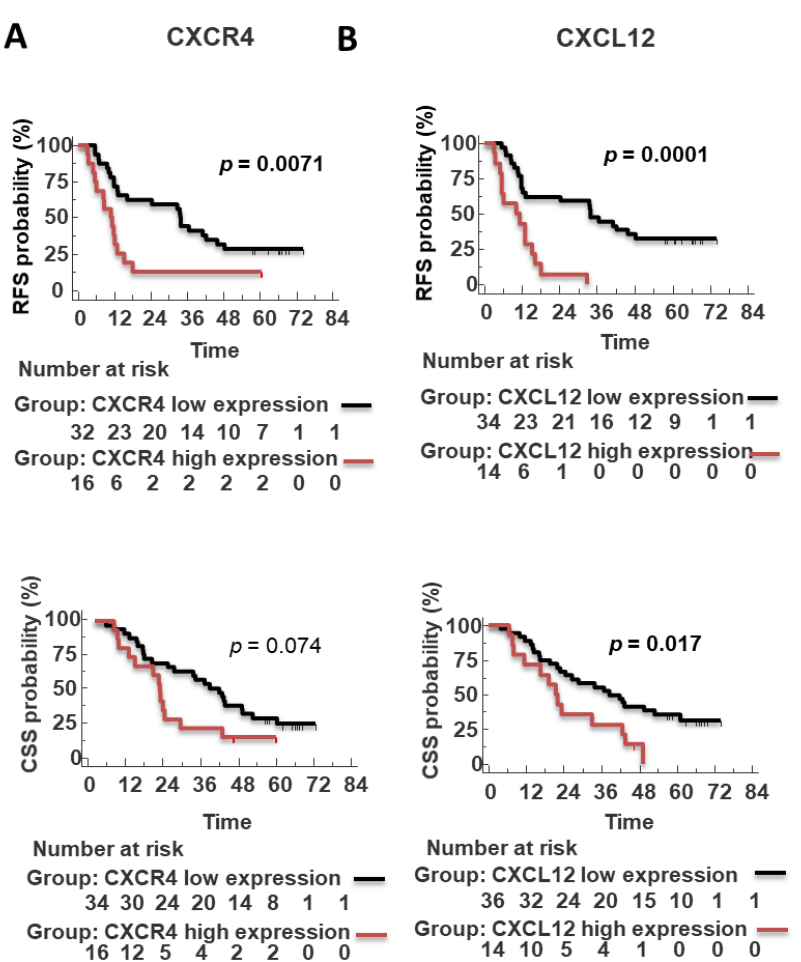
Figure 6. CXCR4 and CXCL12 in tumor cells predict poor prognosis in R0 patients. Survival LogRank analysis correlates recurrence-free survival (RFS) and cancer-specific survival (CSS) (months) of CXCL12 and CXCR4 ( A , B ) expression restricted to with radical resection (R0) PDAC patients subpopulation.